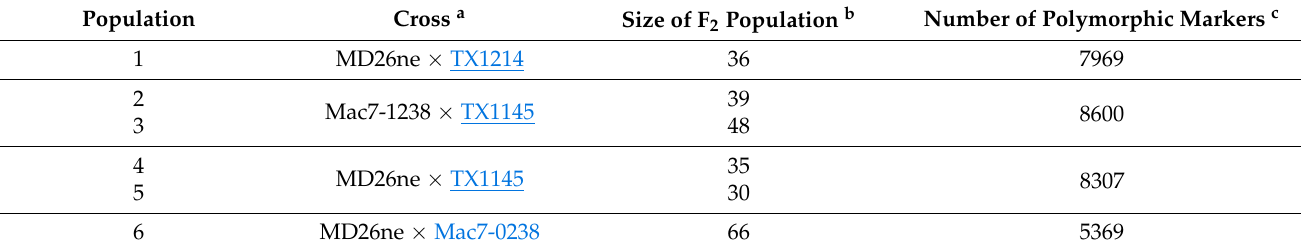
a List of population crosses. Blue indicates the resistant parent and black indicates the susceptible parent. Underline indicates a photoperiod sensitive parent. b Number of samples in the cross. c Number of polymorphic markers for each